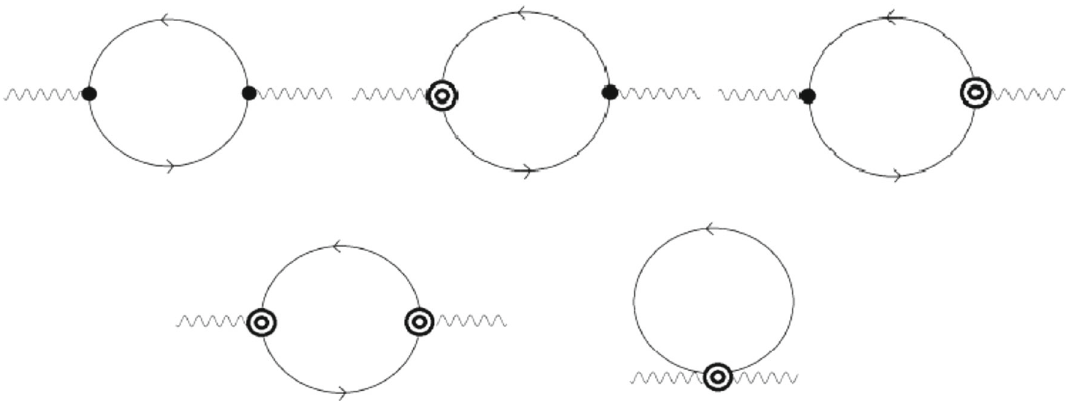
Fig. 3 The diagrams with two gluon legs: ( 2 , 0 , 0 , 2 ), 2 × ( 2 , 0 , 0 , 1 ), 2 × ( 2 , 0 , 0 , 0 ) , contributing to the primite divergences. Only diagrams